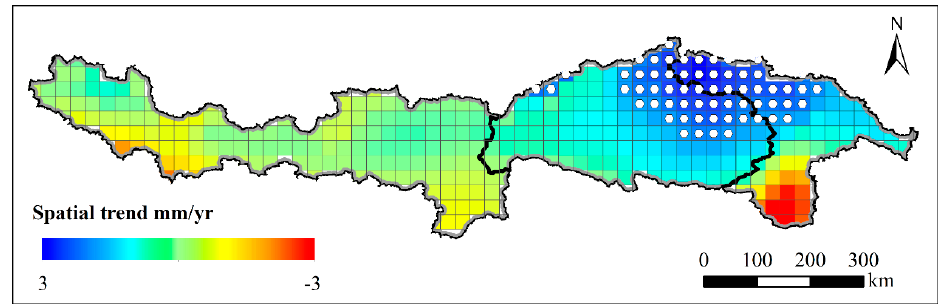
Figure 10. The spatial variation trend of the soil moisture in the YZR basin. The white point represents a significantly increasing trend at the 0.05 significance level.